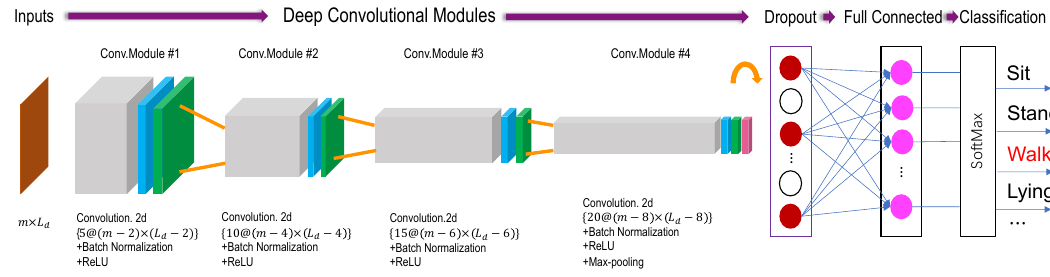
Figure 4. The structure of Deep Convolutional Neural